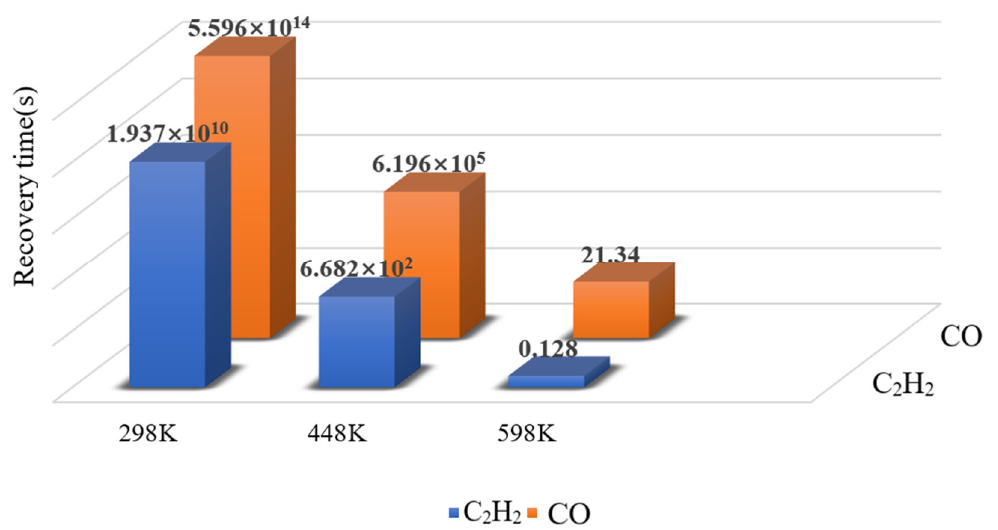
Figure 7. Recovery time for two species at various temperatures.